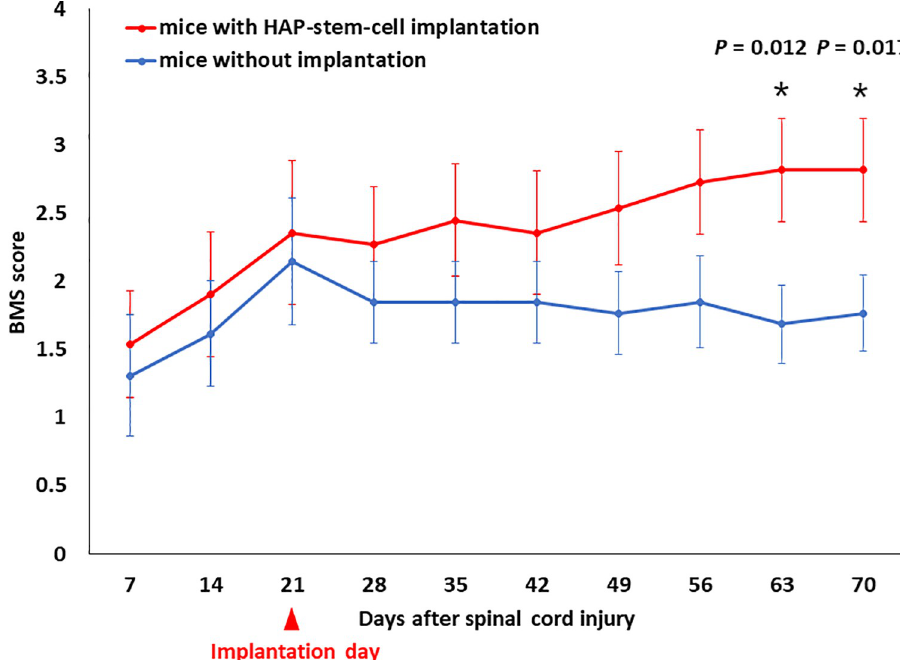
Fig 7. Motor function analysis of HAP-stem-cell implanted mice. Basso Mouse Scale for Locomotion (BMS) score for each group over the 70 days post-SCI. Although there was no significant difference in the BMS score among mice implanted with HAP stem cells and mice without HAP-stem-cell implantation until day 56, mice implanted with HAP stem cells exhibited significantly better functional recovery than mice without HAP-stem-cell implantation on day 63 and thereafter. (mice with HAP-stem-cell implantation: n = 11; control mice without implantation: n = 13). � P < 0.05.